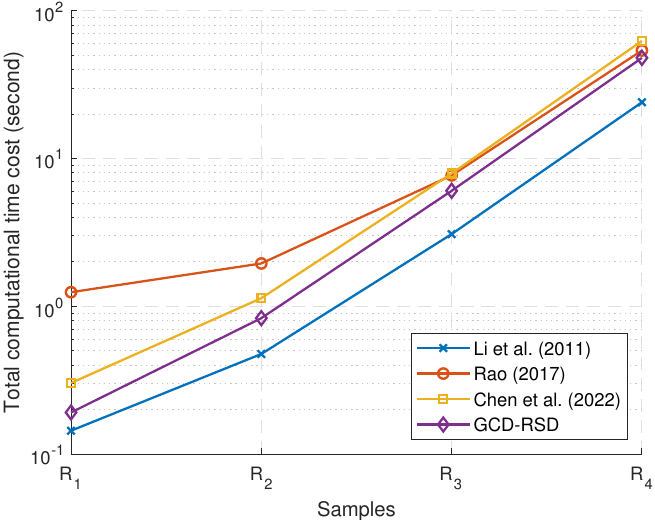
Figure 6. The comparison of the total time cost for 4 schemes [17,19,28] and GCD-RSD to distribute R 1 , R 2 , R 3 , and R 4 , i.e., the total time consumption of Sign (or Signcrypt ) and Verify (or Unsigncrypt